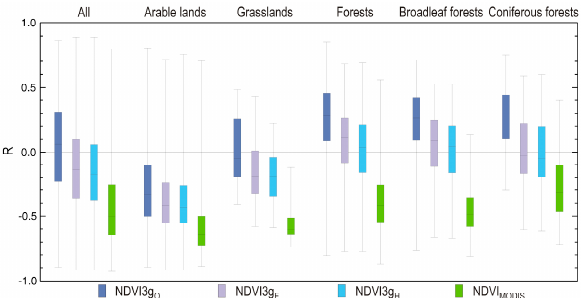
Figure 7. Box-whisker plots of the correlation coefficients between the temperature anomaly and the NDVI anomaly in August derived from the NDVI3g O (dark blue, the first column in every LC group), NDVI3g F (purple, the second column in every LC group), NDVI3g H (light blue, the third column in every LC group) and NDVI MODIS (green, the fourth column in every group) datasets for all vegetated pixels of the study area, and for different land cover types. (Box-whisker plots are indicating maximum, upper quartile, median, lower quartile, and minimum values.)